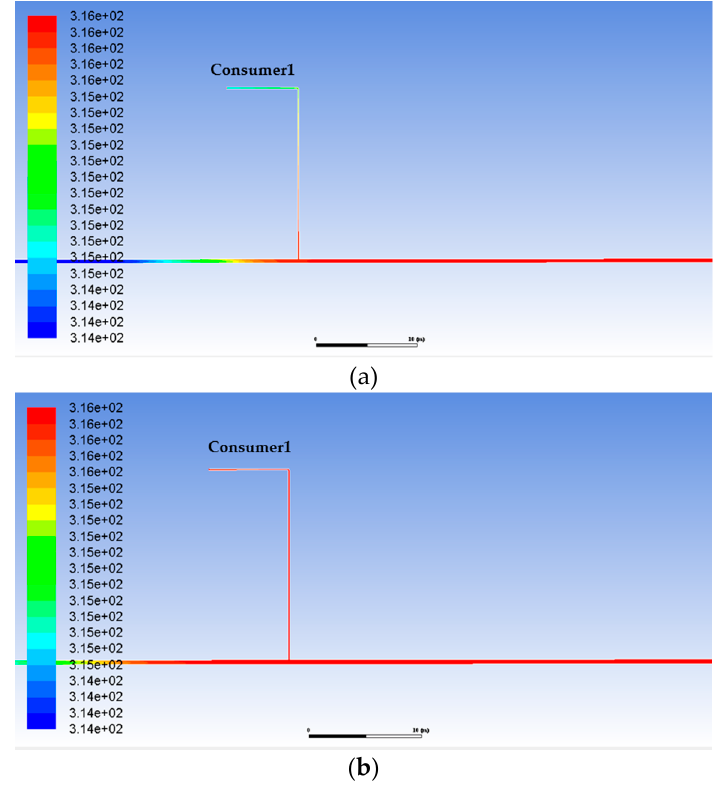
Figure 7. (a) The temperature of Consumer 1 at 220 s; (b) the temperature of Consumer 1 at 240 s. Figure 7. ( a ) The temperature of Consumer 1 at 220 s; ( b ) the temperature of Consumer 1 at 240 Table 3. The delay time of the heat consumer.